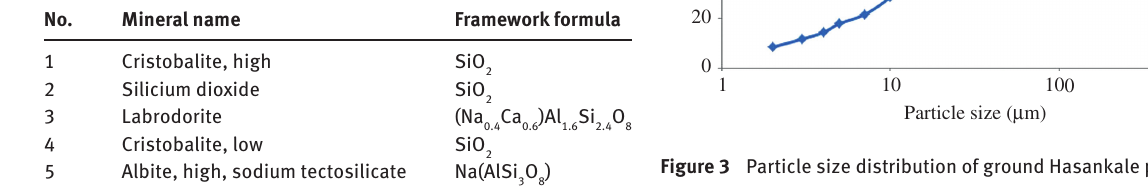
Figure 3 Particle size distribution of ground Hasankale